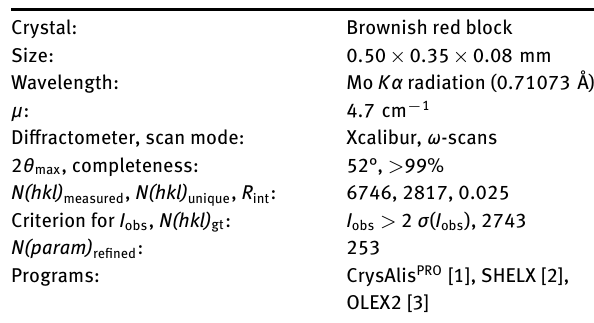
Table 1: Data collection and handling.